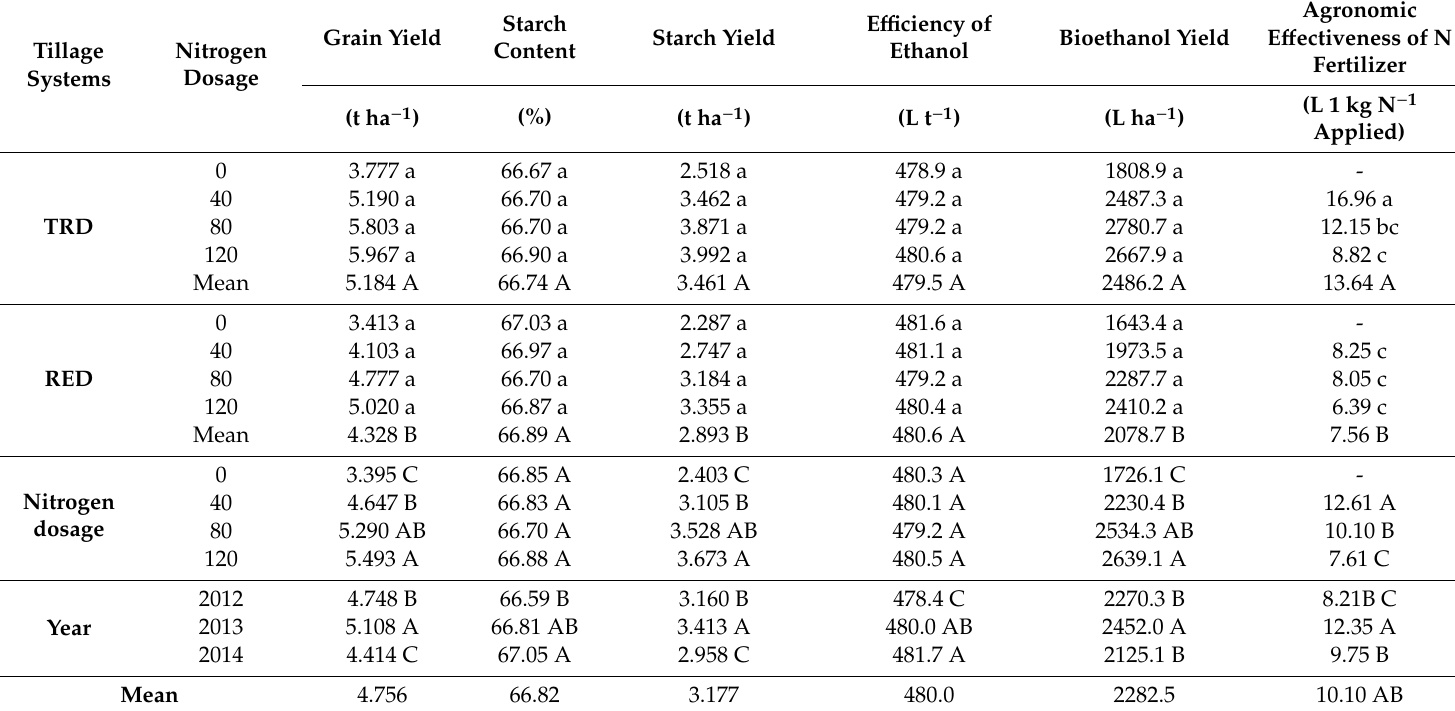
Table 2. Grain yield and bioethanol yield of spring triticale as a ff ected by N